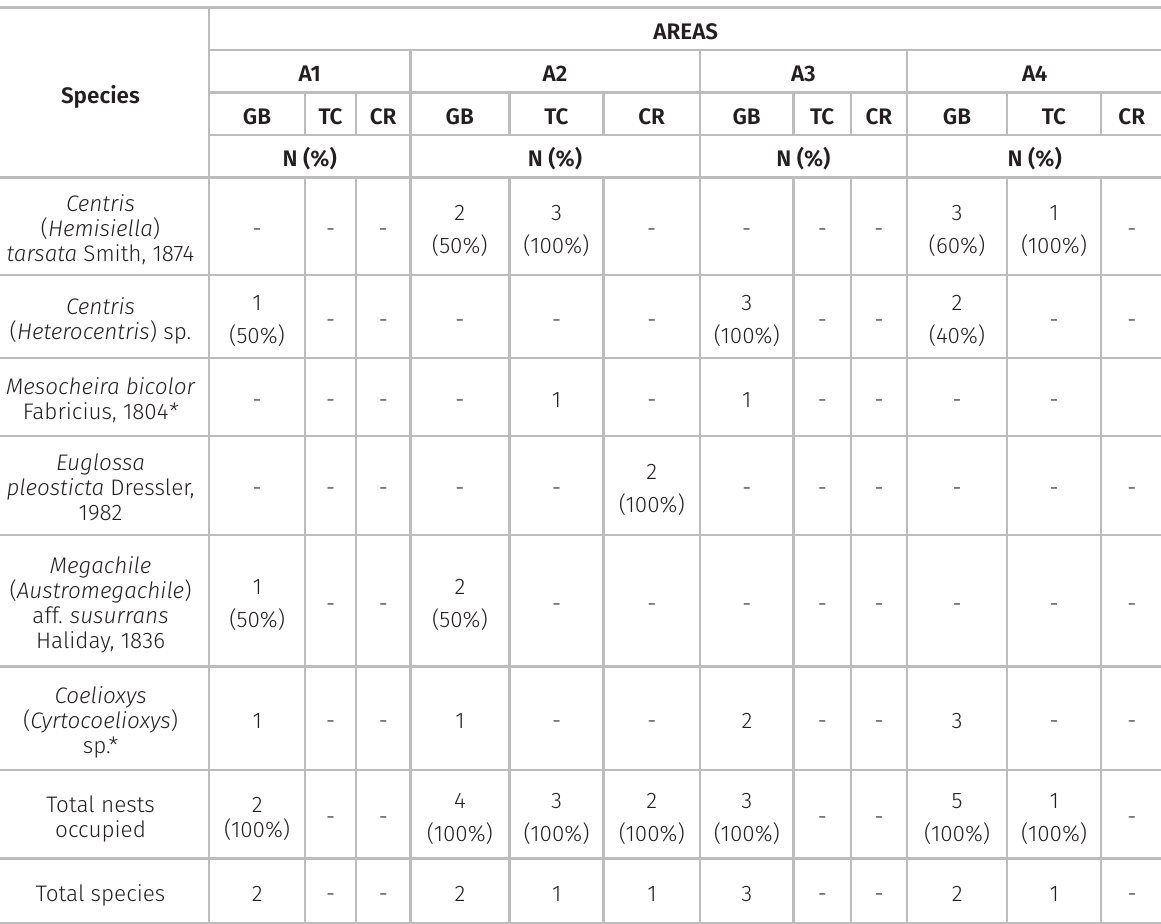
Table III. Species of bees and occupation of different types of trap-nests (GB = Bamboo internodes; TC = Cardboard tubes; CR = Wooden box) in the four studied areas, from September 2012 to November 2013, Baturité Massif,